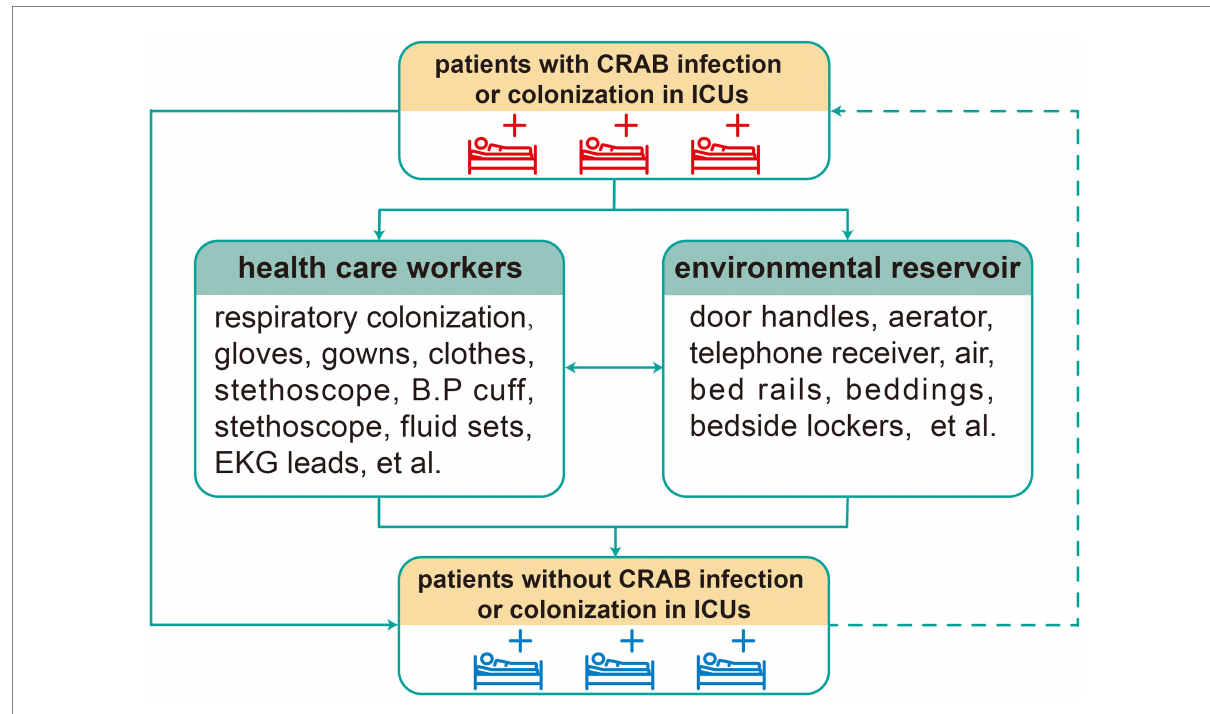
FIGURE 1 Transmission relationship of CRAB in ICUs. Solid arrow: bacterial infection and dissemination; dotted arrow: patients recently infected and colonized with CRAB are viewed as the new transmission